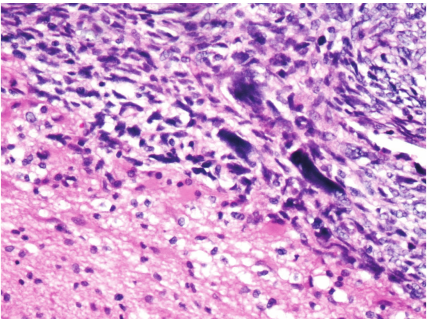
Figure 14: Metastatic sarcoma and edematous brain tissue interface. H&E: × 200.